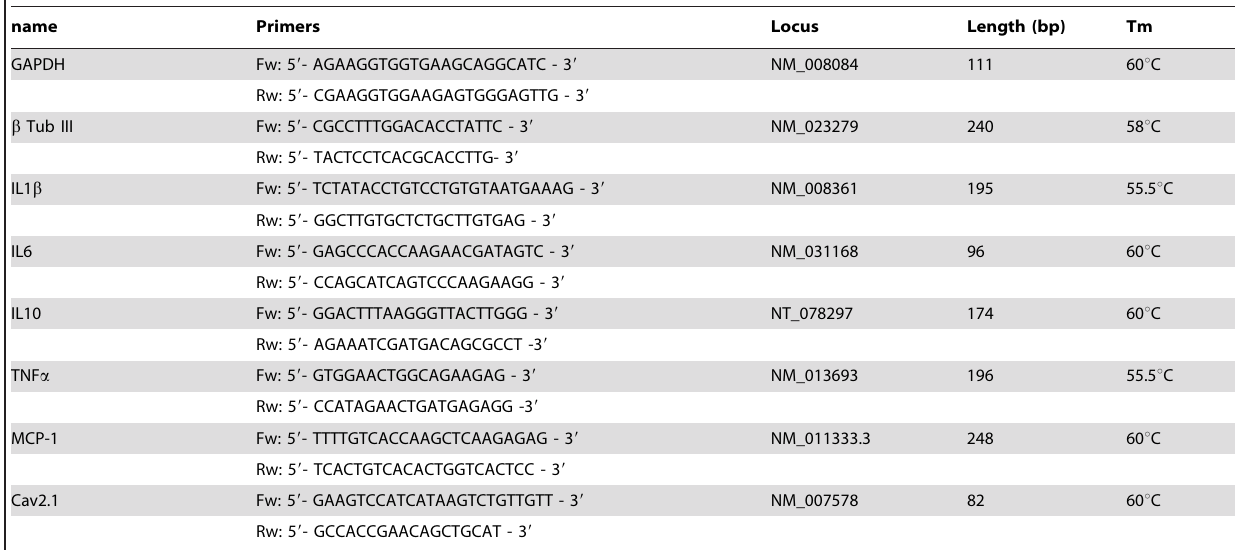
Table 1. Real time PCR